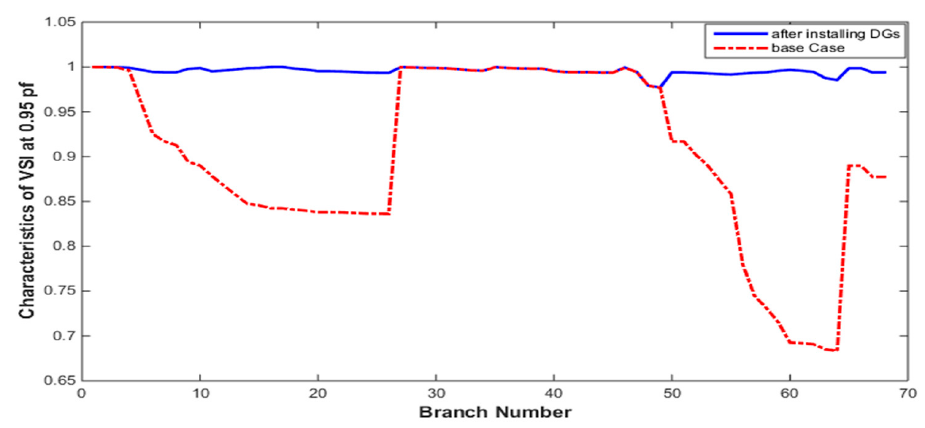
Figure 24. Characteristics of voltage at 0.95 pf.